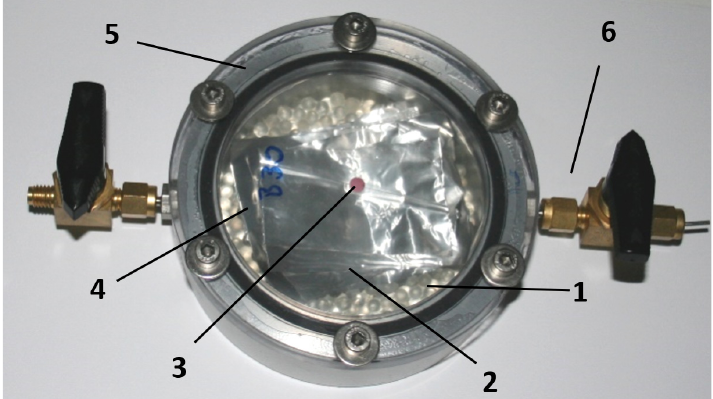
Figure 3. Experimental packaging [Fraunhofer IVV], 1: glass beads to adjust headspace volume, 2: film with oxygen scavenger, 3: oxygen sensor (from PreSens), 4: PET film, thickness 50 µm with defined oxygen transmission rate, 5: clamping ring, 6: valves to set the initial oxygen concentration.